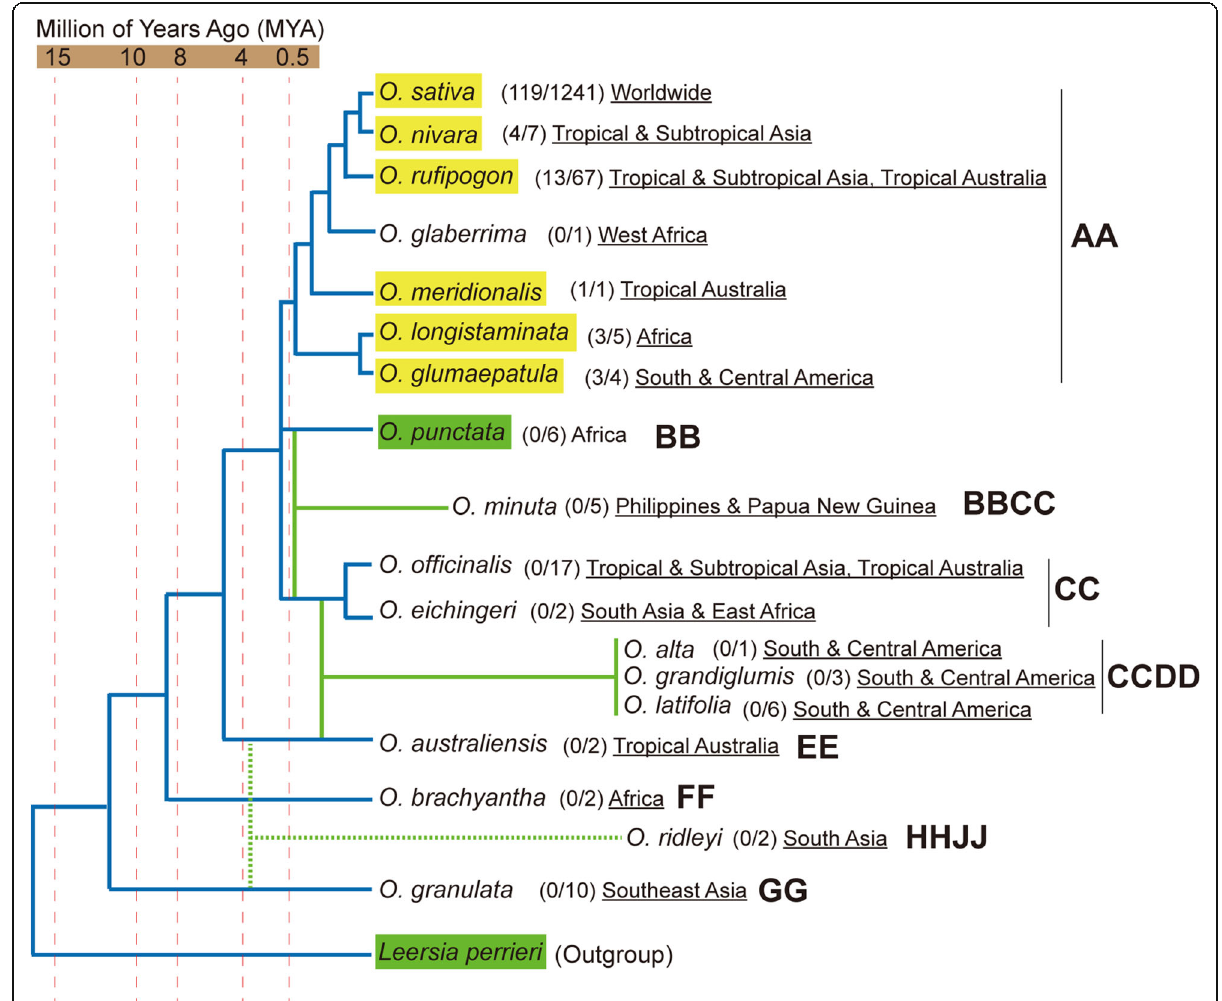
Fig. 6 Xa7 alleles survey in the Oryza genus. The phylogenetic tree of the Oryza genus and outgroup Leersia perrieri was modified from the articles by Kellogg (2009) and Jacquemin et al. (2013). The divergence time is based on data from the literature (Ammiraju et al. 2008; Guo and Ge, 2005; Tang et al. 2010; Wang et al. 2009). The result of the Xa7 CDS amplification is shown in brackets: The denominators indicate the number of landraces and wild rice species used for the detection, while the numerator indicates the positive number of the detections. Geographical distribution information is underlined. The genome type is indicated in bold font. The species carrying Xa7 alleles based on experimental detection are highlighted in yellow. The species carrying Xa 7 homologs based on a BLAST at UniProt database, are highlighted in green. Accessions with a hit Score>300, an identity >60%, and an E-value <1e-30 were classified as XA7